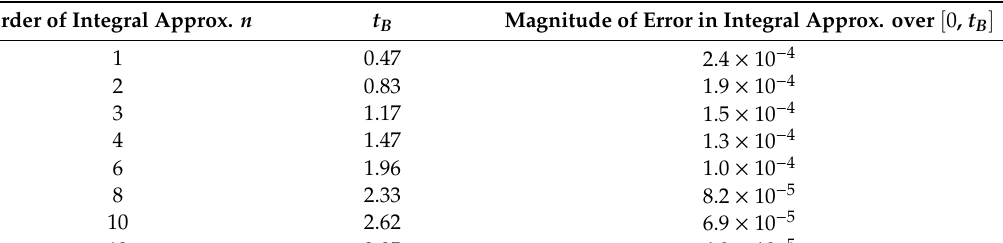
Table 1. Interval of integration for a spline based approximation and for a specified error bound of ε B = 10 − 3 . Order of Integral Approx. n